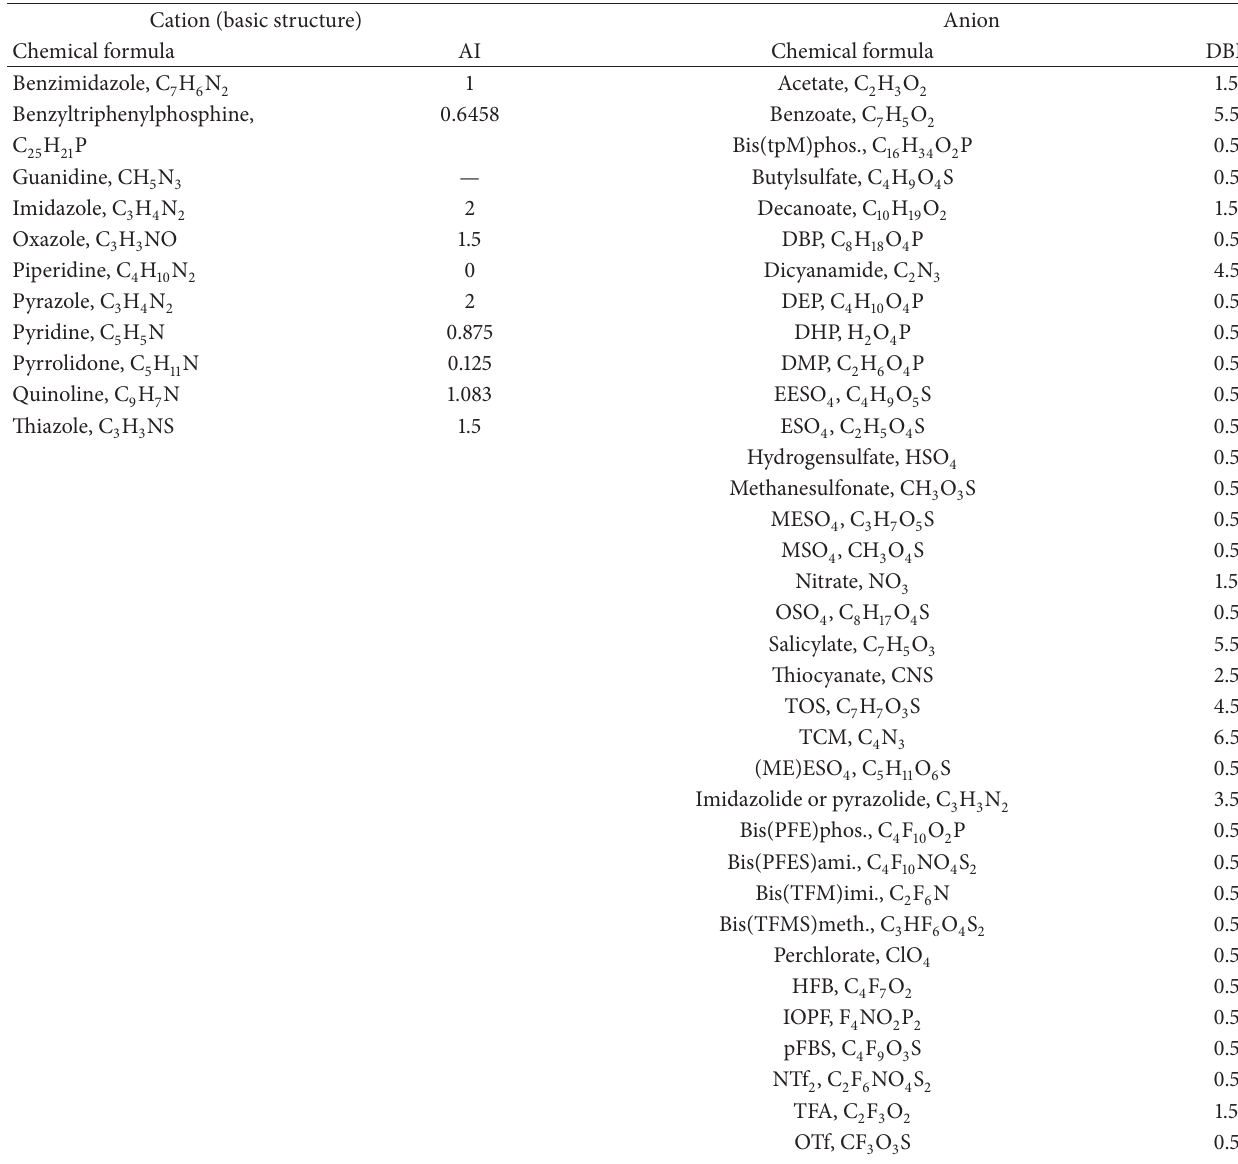
Table 1: Calculated aromaticity index (AI) and double-bond equivalent (DBE) value for common cation and anion. Cation (basic